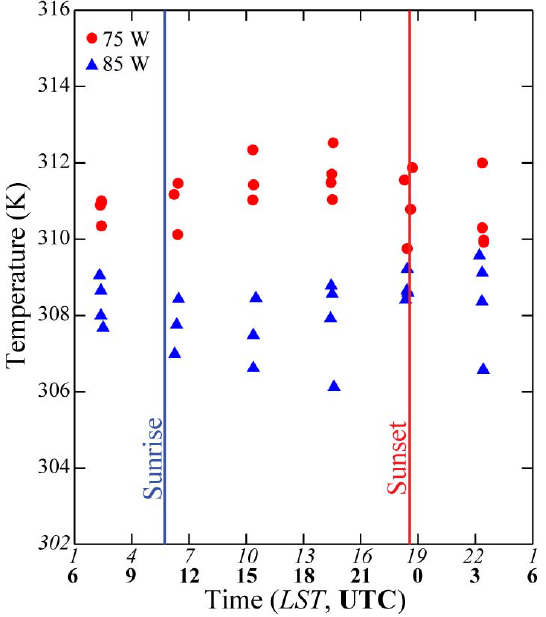
Fig. 13. Observed potential temperature (K) at 2.5-km for each day at which the R/V Ron Brown was stationed at 20 ◦ S, 75 ◦ W (circles) and 20 ◦ S, 85 ◦ W (triangles). Blue and red vertical lines indicate approximate local sunrise and sunset,